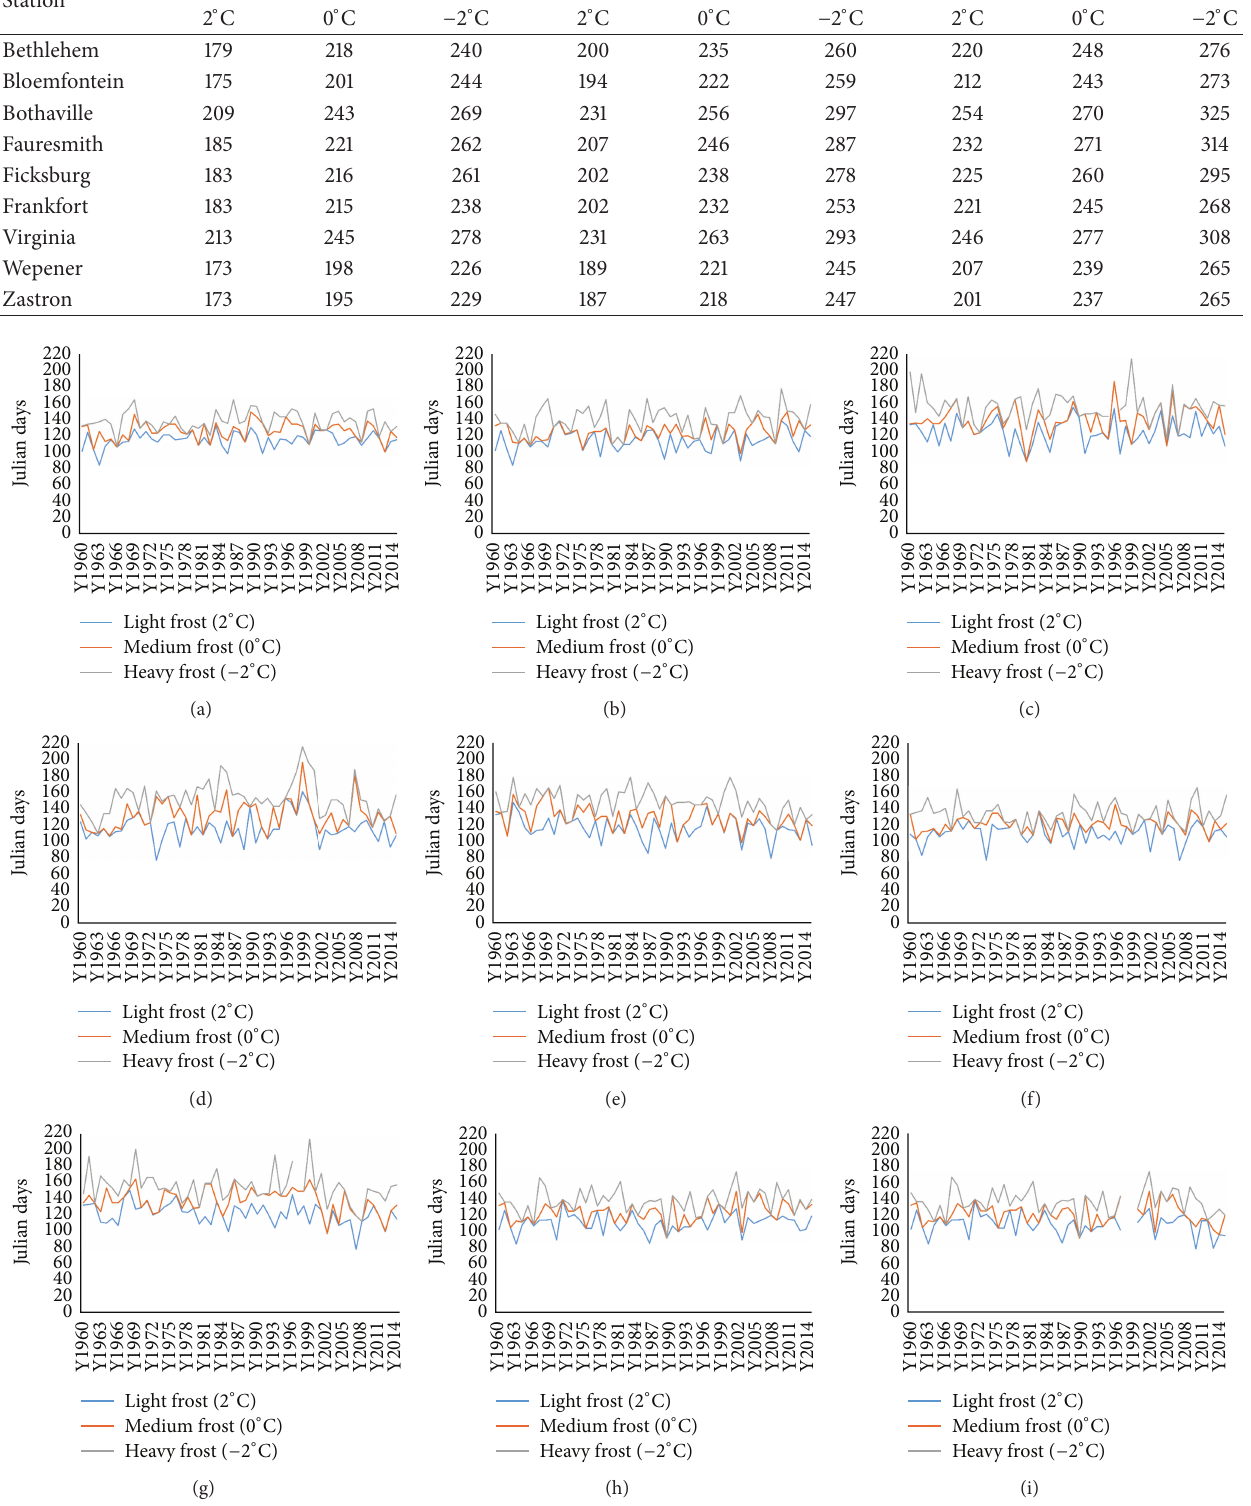
Table 5: Frost-free duration (in days) at different probability levels (20%, 50%, and 80%) and thresholds (2 ∘ C, 0 ∘ C, and − 2 ∘ C). Station